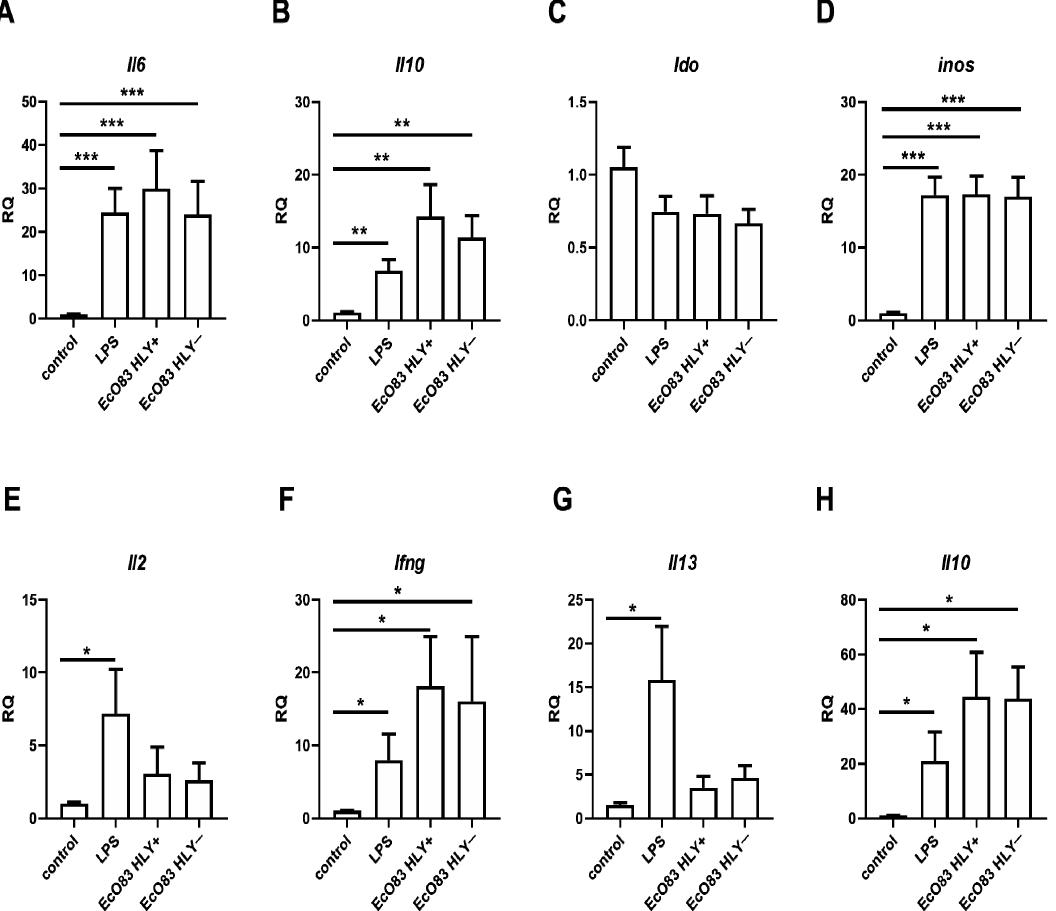
Figure 2. Gene expression in bone marrow-derived dendritic cells and CD4 + T cells. Bone marrow dendritic cells were stimulated by hemolysin positive (HLY+) or hemolysin negative (HLY − ) strains of E. coli O83:K24:H31 (EcO83), with LPS as a positive control. Gene expression was determined by quantitative real-time PCR (qPCR) after 5 h stimulation. Detection of proinflammatory cytokine Il6 , ( A ), measurement of immunoregulatory markers: Il10 , ( B ) and indol-amine 2,3 dioxygenase ( Ido